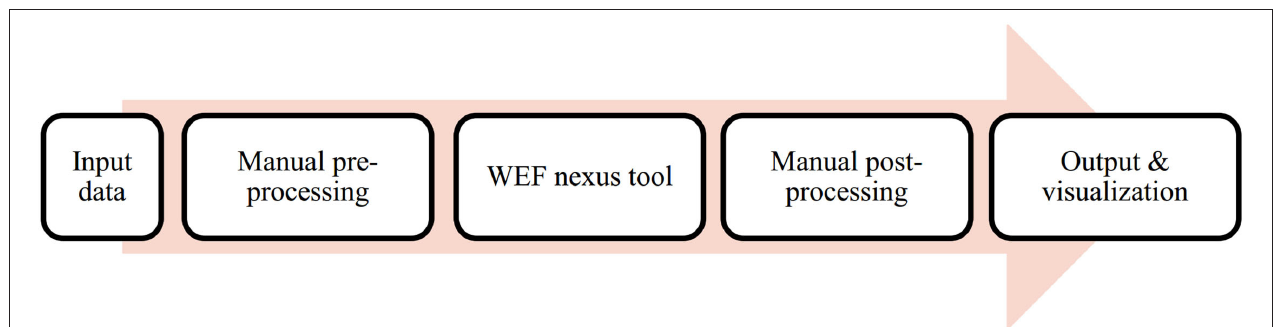
FIGURE 9 | Manual operation of “soft-linked” WEF nexus tool and geospatial capabilities from user’s perspective (adapted from Burger, 2018 and Burger and Abraham, 2020).